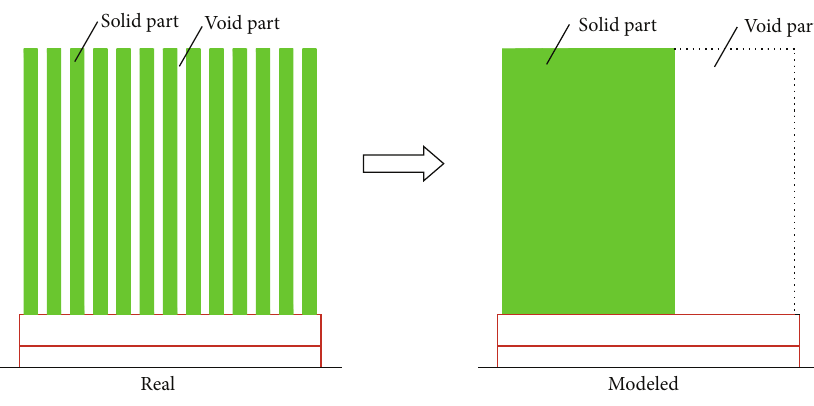
Figure 12: Modeling of the